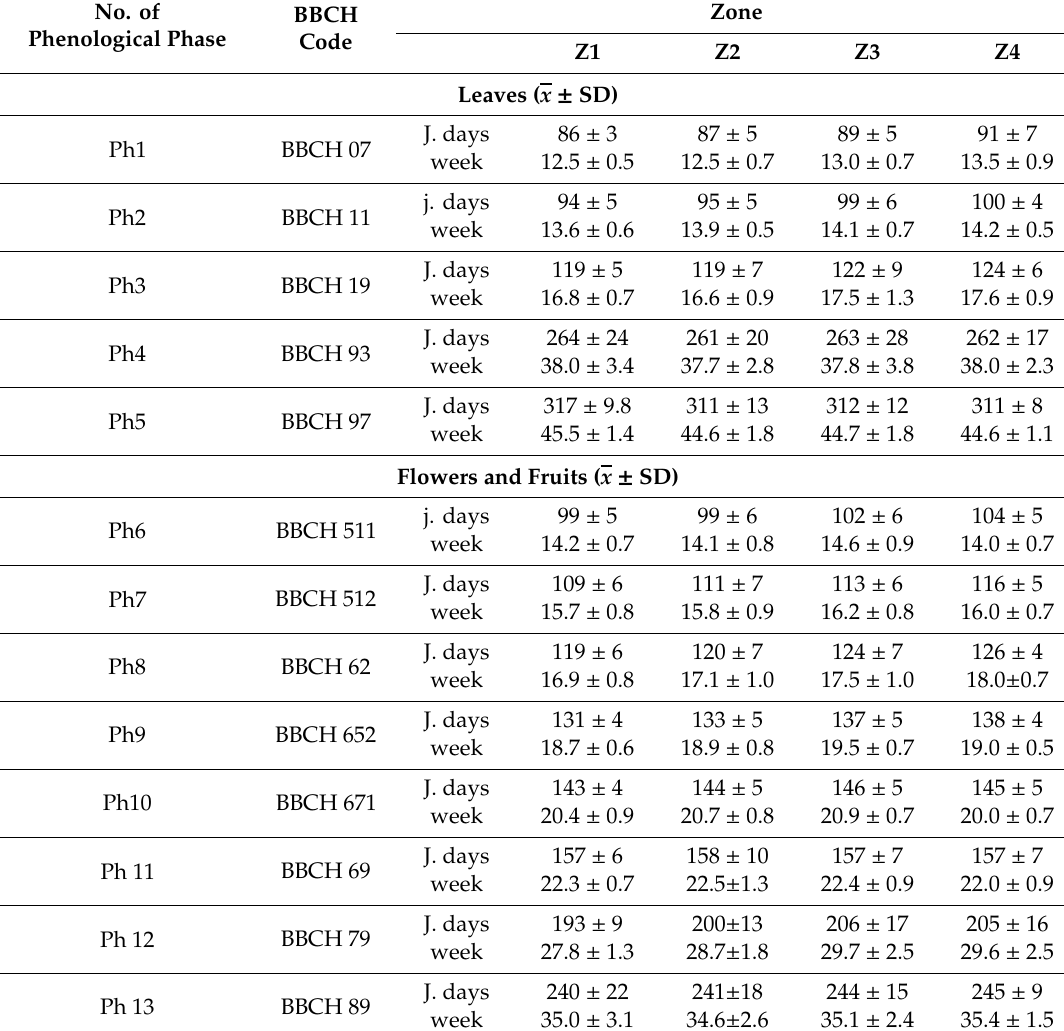
Table 3. Average onset ( x ) date and standard deviation (SD) of occurrence of individual phenological phases depending on the distance from the city center [in weeks and Julian